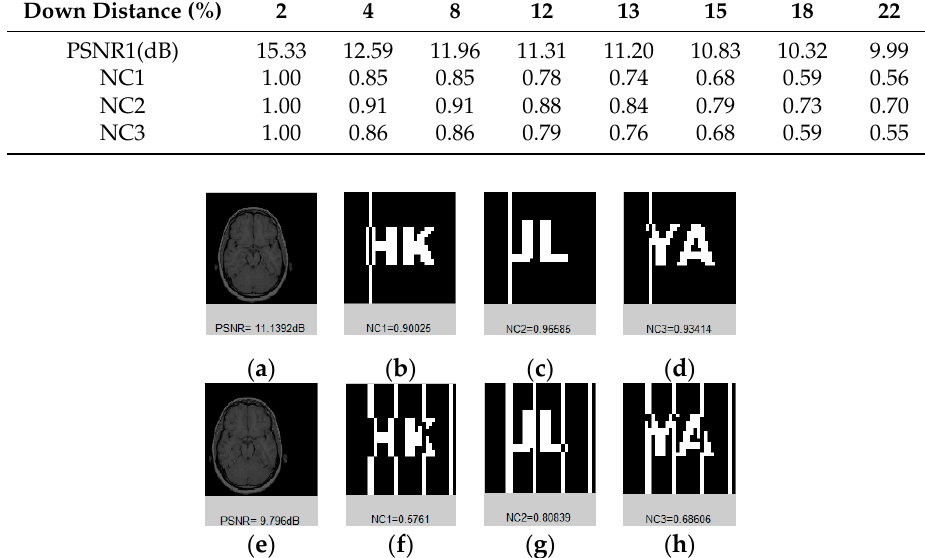
Figure 21. Under left translation attacks: (a) Left distance 7%; (b) the extracted watermark 1 under left distance 7%; (c) the extracted watermark 2 under left distance 7%; (d) the extracted watermark 3 under a left distance of 7%; (e) Left distance 11%; (f) the extracted watermark 1 under a left distance of 11%; (g) the extracted watermark 2 under a left distance of 11%; (h) the extracted watermark 3 under a left distance of 11%. Table 9. Data of left translation attacks.